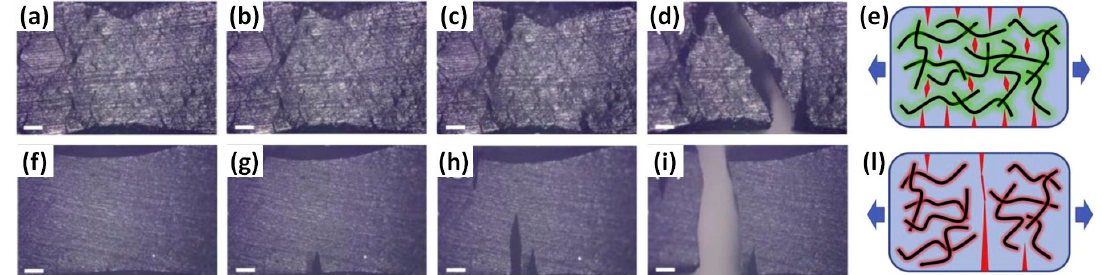
Figure 8. Images of tensile testing on uniformly distributed CNTs in epoxy ( a )–( d ) and agglomerated CNTs in epoxy ( f )–( i ) under different moments (scale bar is 200 mm); ( e ) and ( l ) possible crack propagation mechanisms. Adapted with permission [101].